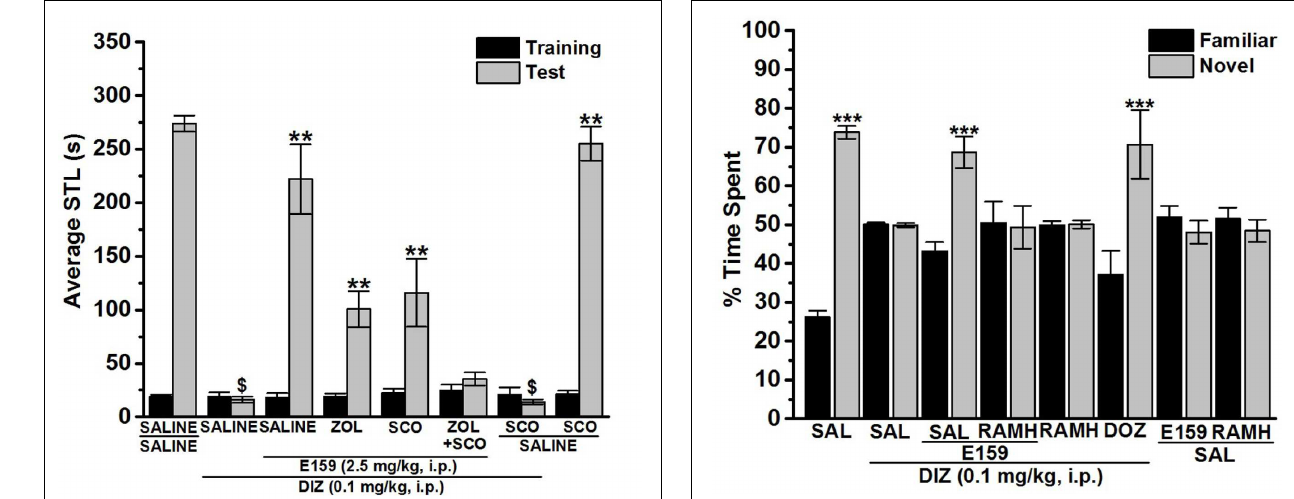
FIGURE 4 | Effect of vehicle, E159, ZOL, and SCO on DIZ-induced deficit in an inhibitory avoidance conditioned response in rats. Gray columns represent the mean STLs measured during the retention test (test latencies) and black columns the mean STLs measured during the training trial before the delivery of the foot-shock (pre-shock latencies). Rats were injected with E159 (2.5 mg/kg, i.p.), ZOL (10 mg/kg, i.p.), SCO (1 mg/kg, i.p.) or a combination of ZOL (10 mg/kg) + SCO (1 mg/kg) 30–45 min before the test session. $ P < 0.001 for mean STLs vs. the value of the (Saline)-treated group. ∗∗ P < 0.001 for mean STLs vs. the value of the (DIZ)-treated group. # P < 0.05 for mean STLs vs. the value of the (DIZ + E159 + ZOL)- and (DIZ + E159 + SCO)-treated group vs. the value of the (DIZ)-treated group. Data are expressed as mean ± SEM ( n = 7).